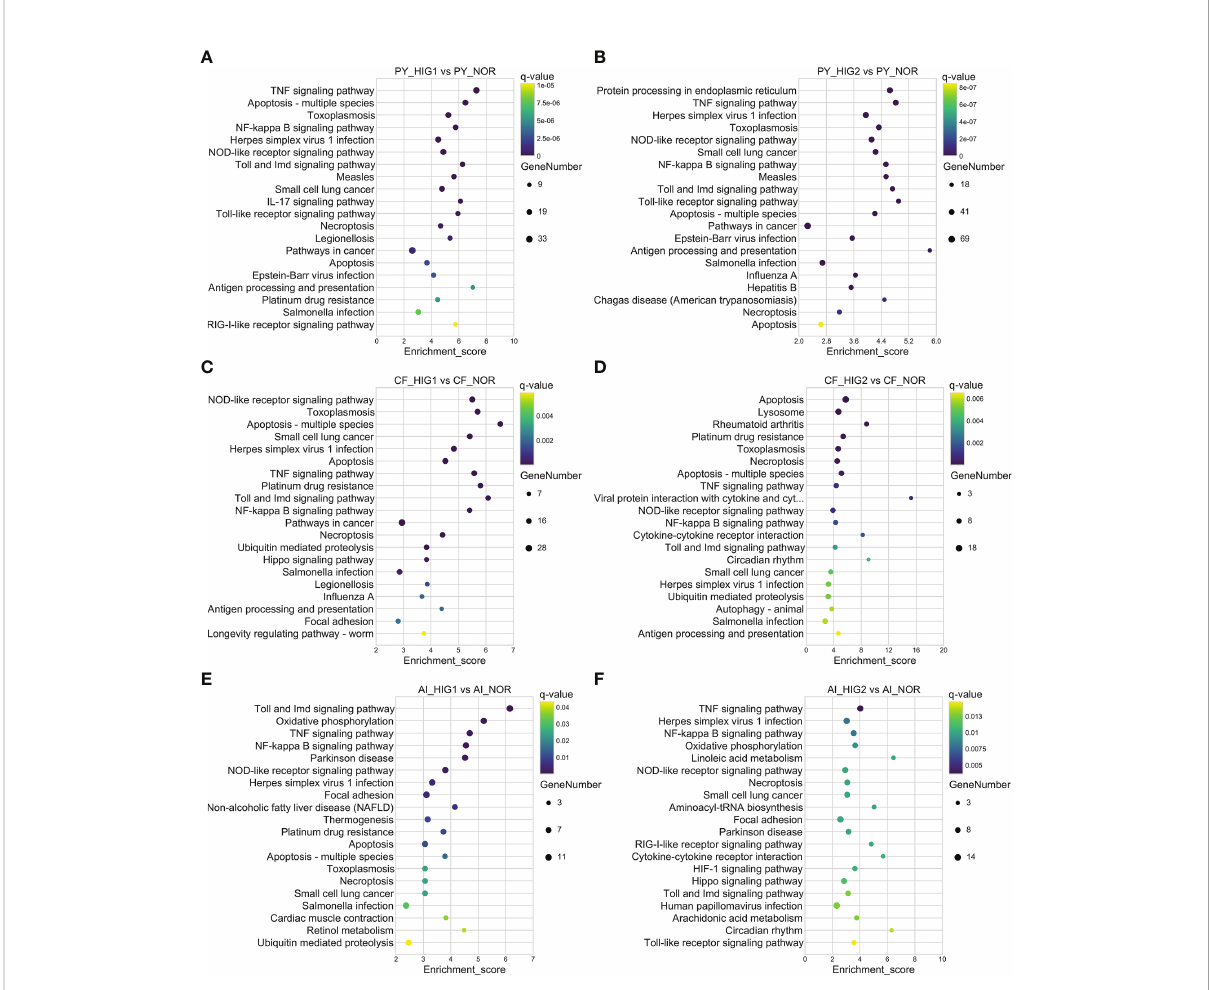
FIGURE 2 Top 20 signi fi cantly enriched KEGG pathways of upregulated DEGs in the Yesso scallop (A, B) , Zhikong scallop (C, D) , and bay scallop (E, F) exposed to different heat stressors. (PY, Patinopecten yessoensis ; CF, Chlamys farreri ; AI, Argopecten irradians ; HIG1 and HIG2, heat stress at 22 and 25°C, respectively; NOR, normal conditions at 15°C and 8 mg/L